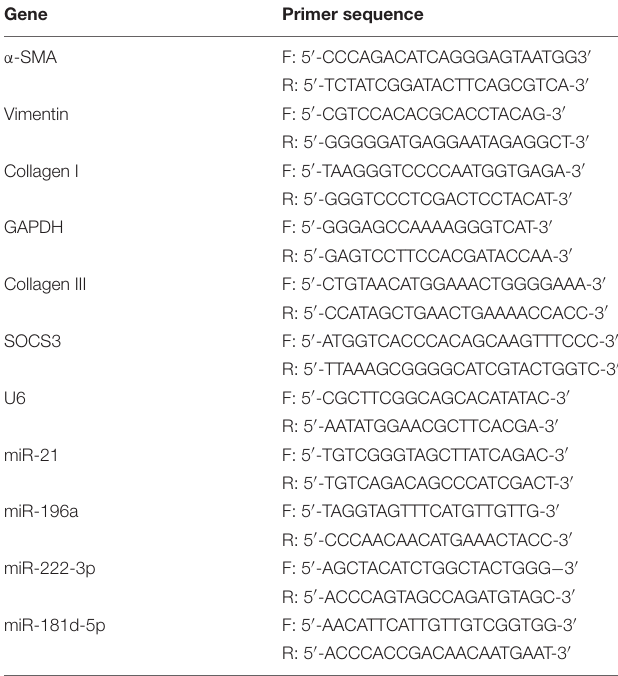
TABLE 4 | Primer sequences for